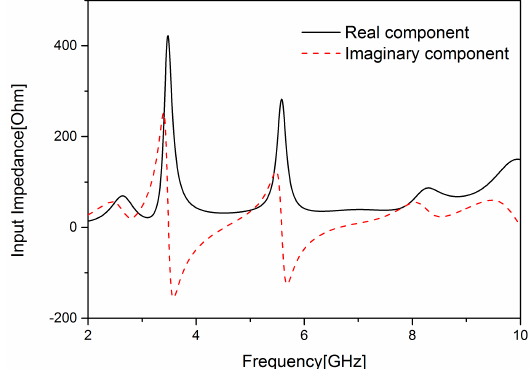
Figure 10. Schematic of the equivalent RLC resonant circuit model of the proposed antenna.